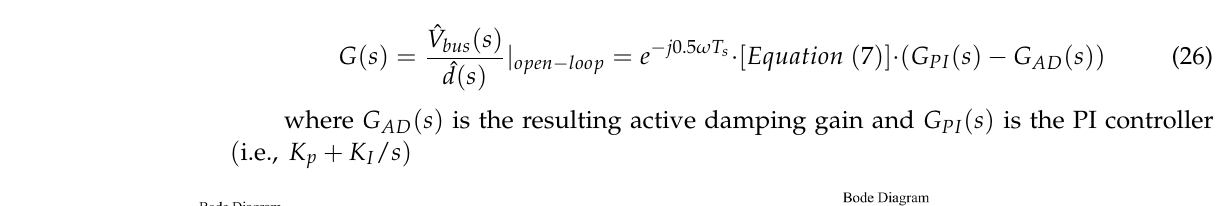
Figure 18. Bode diagram of